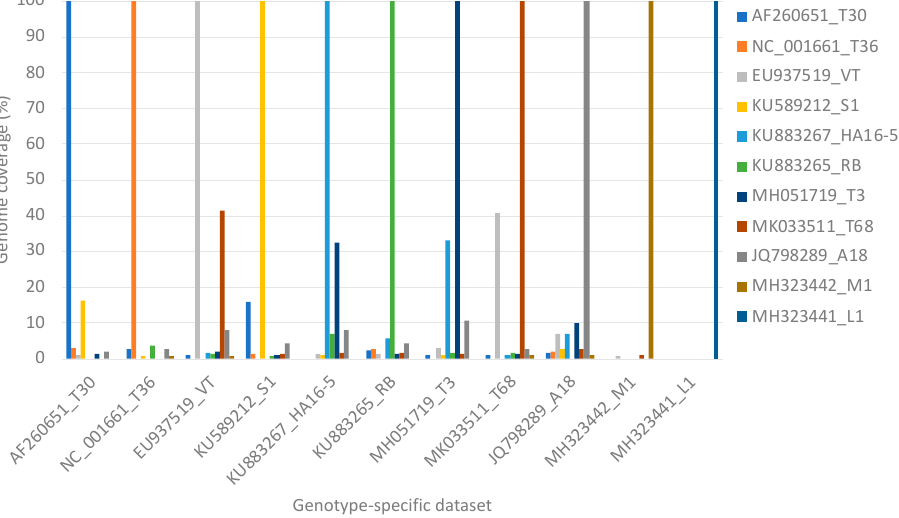
Figure 3. A clustered column chart displaying the genome coverage per representative genotype after read mapping one million read pairs of genotype-specific data on all genotype sequences concurrently.